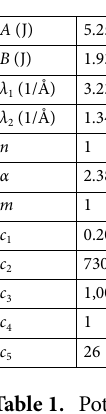
Table 1. Potential parameters of the modified Tersoff